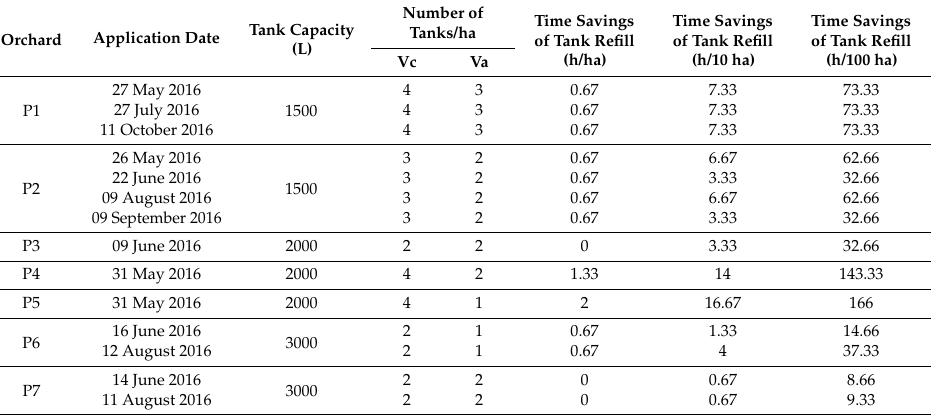
Table 6. Time savings of tank refill for each application and for different size areas to be sprayed, considering an average refilling time of 40 min per tank, including equipment transit time to and from the water source